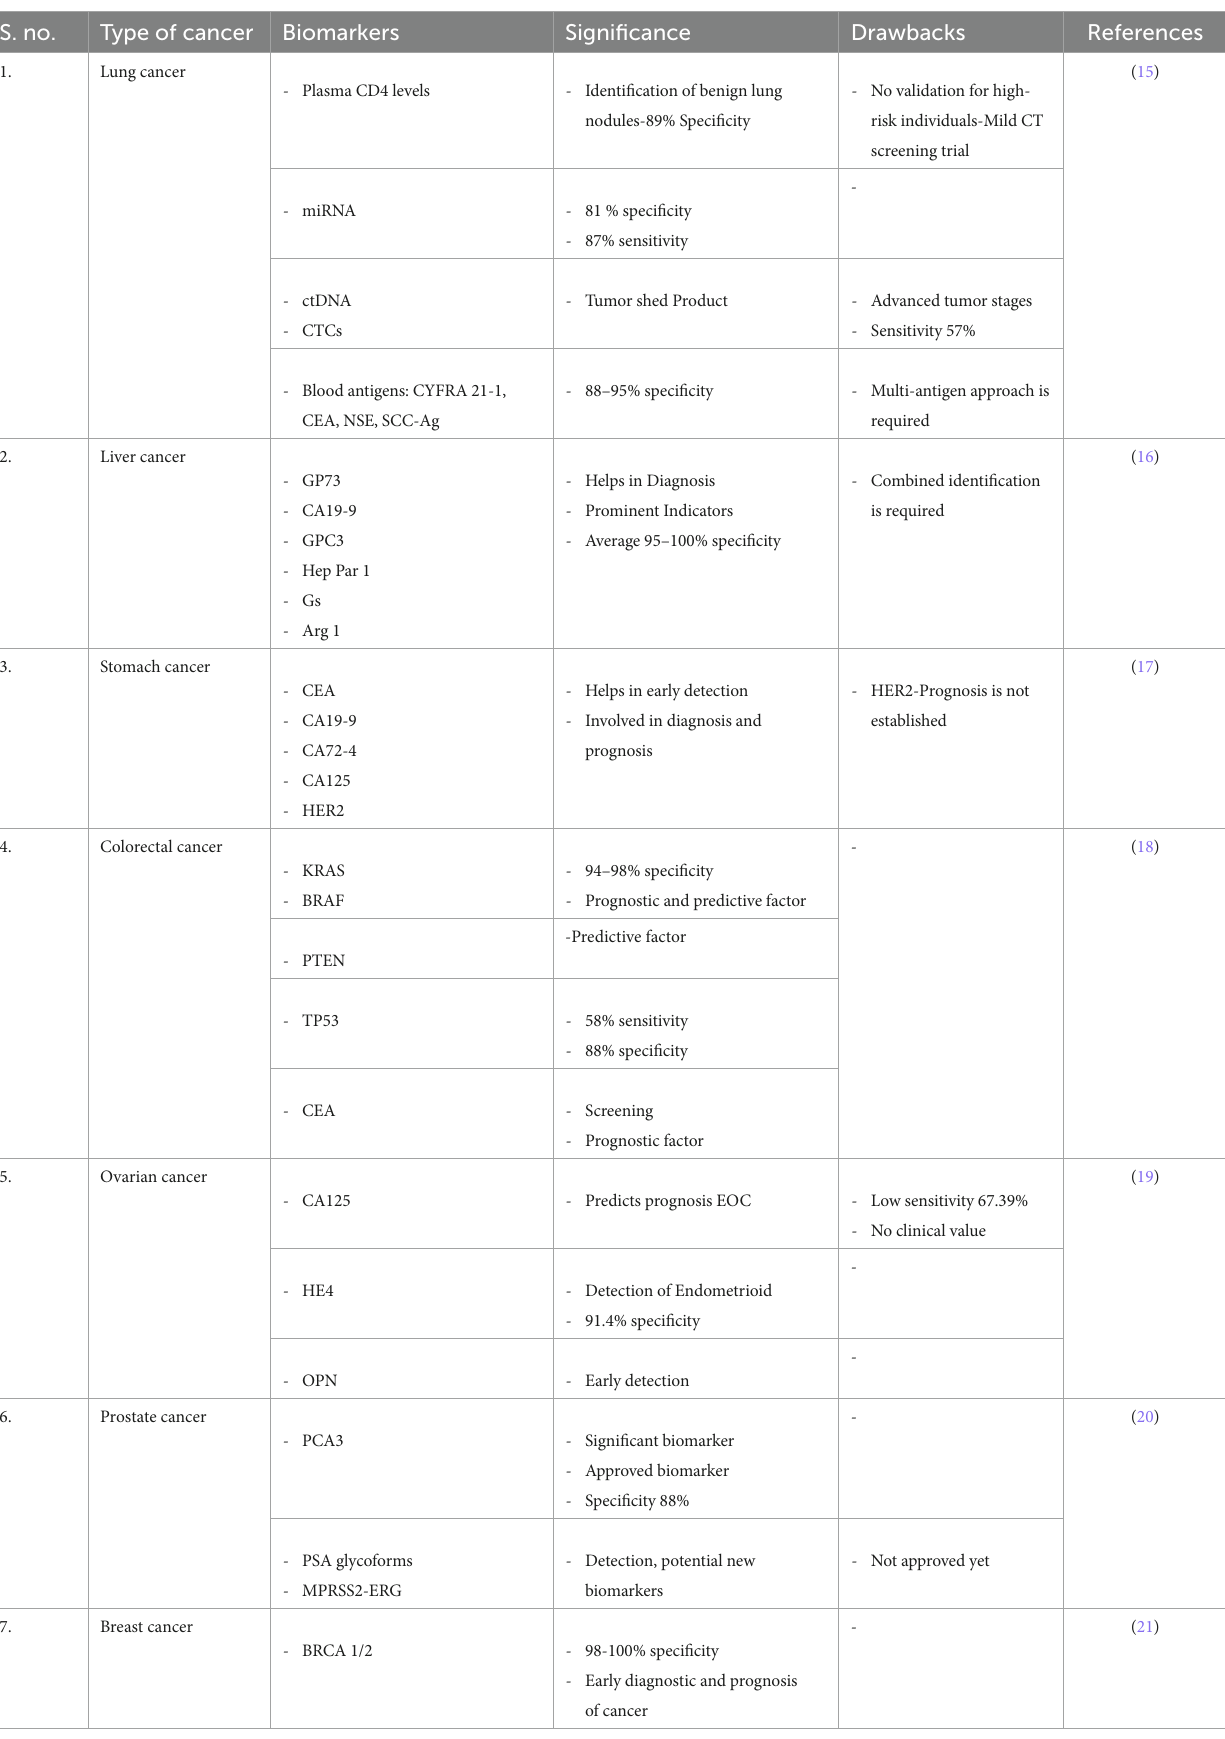
TABLE 1 Biomarkers and their significance in various type of cancers. S.